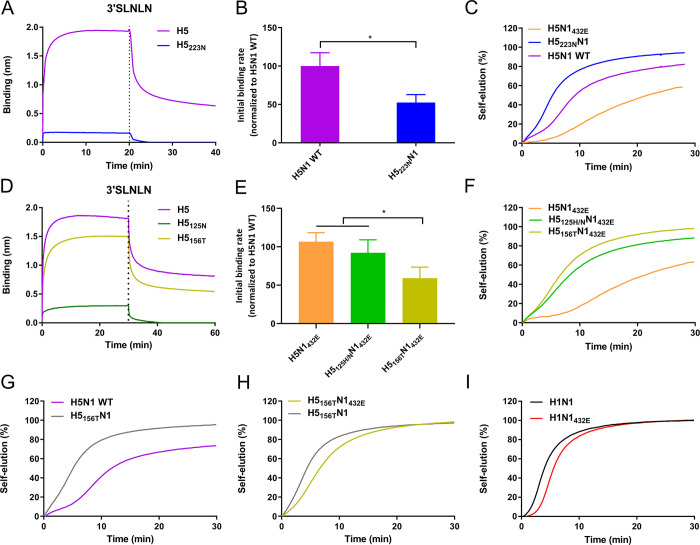
Mutations in HA restore the HA-NA balance.(A and D) Association and subsequent dissociation of indicated H5 proteins complexed with antibodies to and from 3’SLNLN-coated sensors. (B and E) Relative initial binding rates per virus particle (vobs = dB/dT) for LAMP1-coated sensors were determined for H5N1 and H5N1 mutant viruses (H5223NN1, H5156TN1432E, H5125H/NN1432E, and H5N1432E) as described previously [20, 24] and graphed normalized to H5N1. Means of three independent experiments are graphed, standard deviations are shown. The relative initial binding rate per virus particle corresponds to the steepness of the initial part of binding curves (as show in Fig 1) normalized for virus particle numbers. (C and F) NA-driven self-elution of H5N1 and H5N1 mutant viruses from LAMP1-coated sensors was analyzed similarly as described in the legend to Fig 1. (G and H) NA-driven self-elution of H5N1 and H5N1 mutant viruses (H5156TN1 and H5156TN1432E) from LAMP1-coated sensors. (I) Self-elution of H1N1 and H1N1432E viruses from LAMP1-coated sensors. Representative experiments out of 2–3 performed are shown.